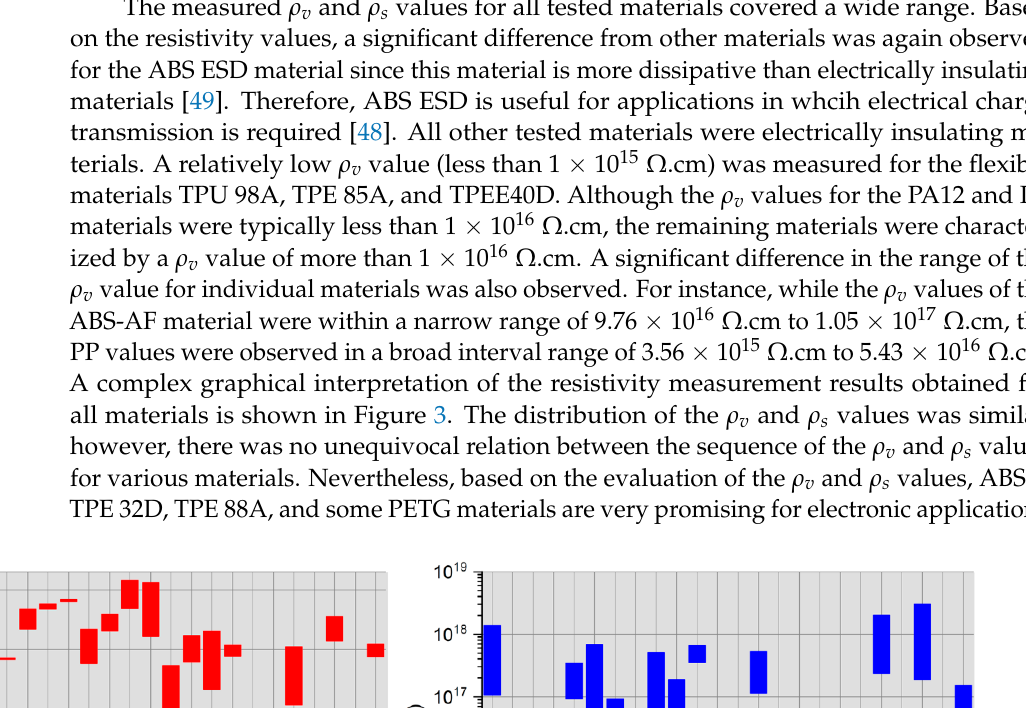
Table 4. Summary of the dielectric constant and loss factor values for all tested materials at three selected frequencies.